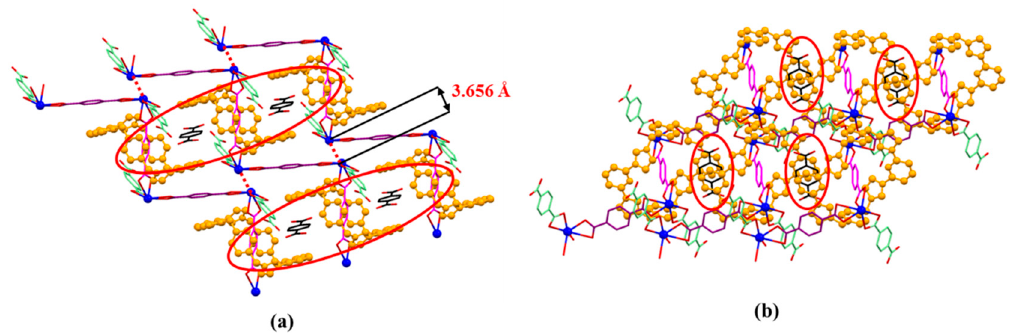
Figure 6. The front ( a ) and side ( b ) views of 2D-array shown in MORF-Pb-1. Terephthalic acid (2H + • 2 ) molecule (highlighted with black colour) inserted into the cavity of MORF-Pb-1 via strong π - π donor–acceptor interactions.